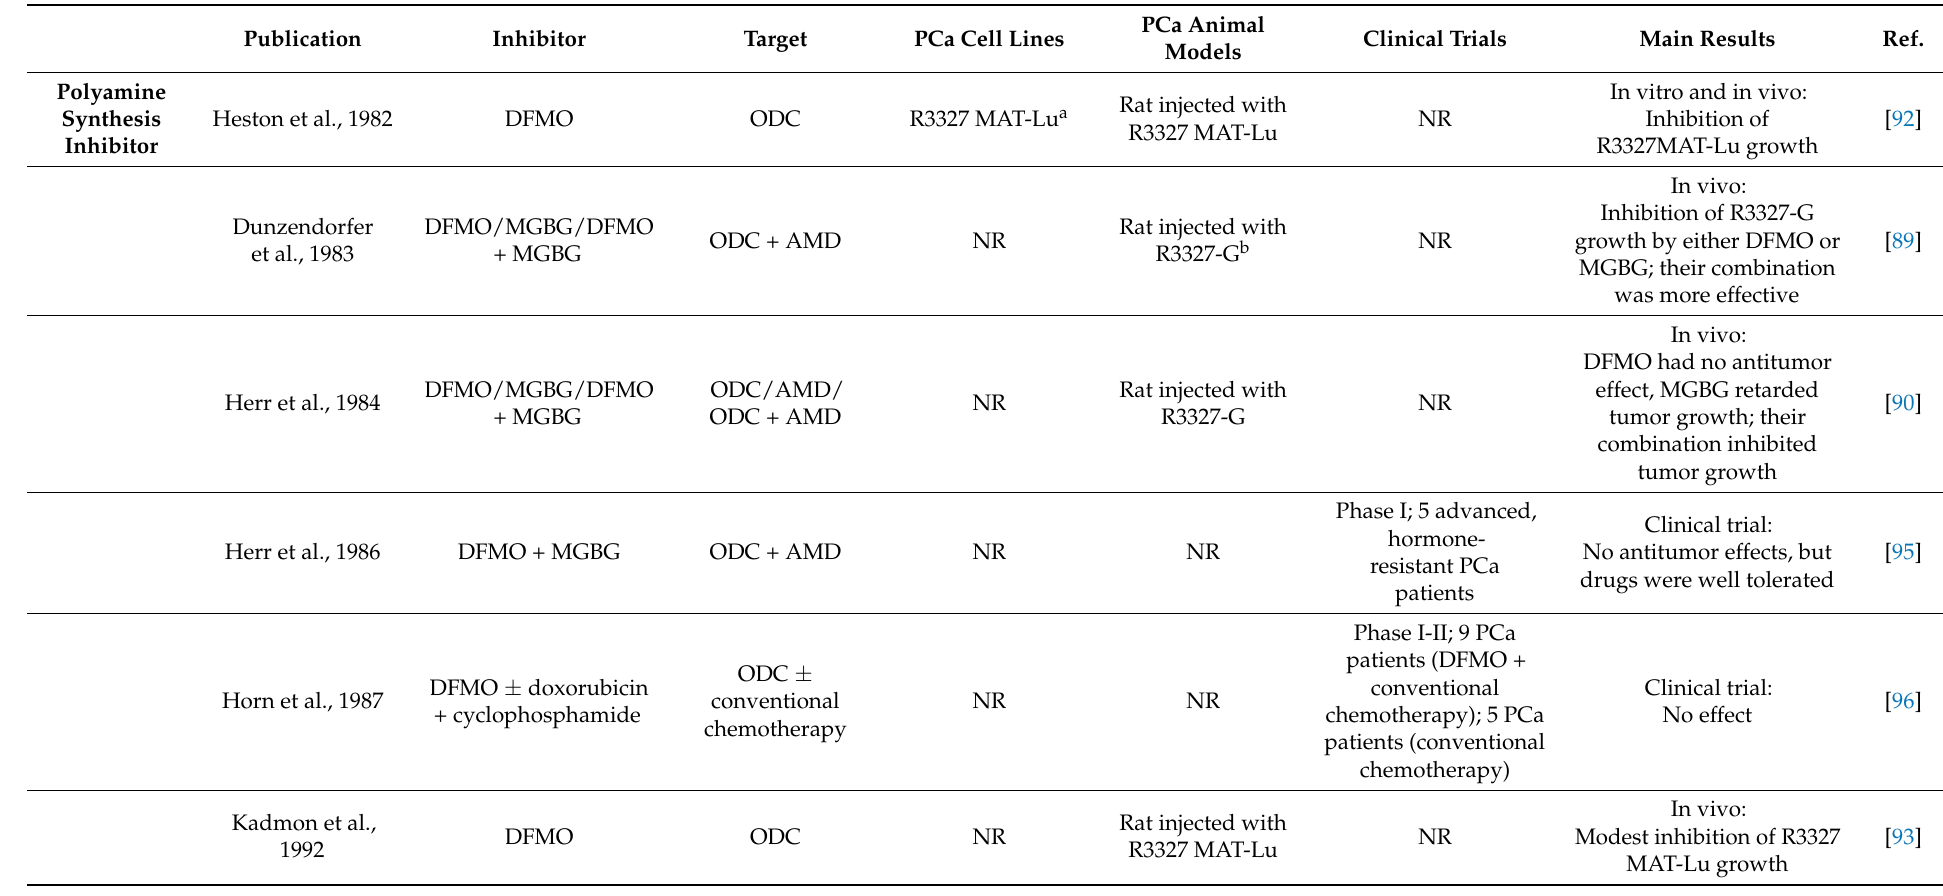
Table 2. Inhibitors targeting spermine metabolism pathway in cell and animal models, as well as clinical trials for